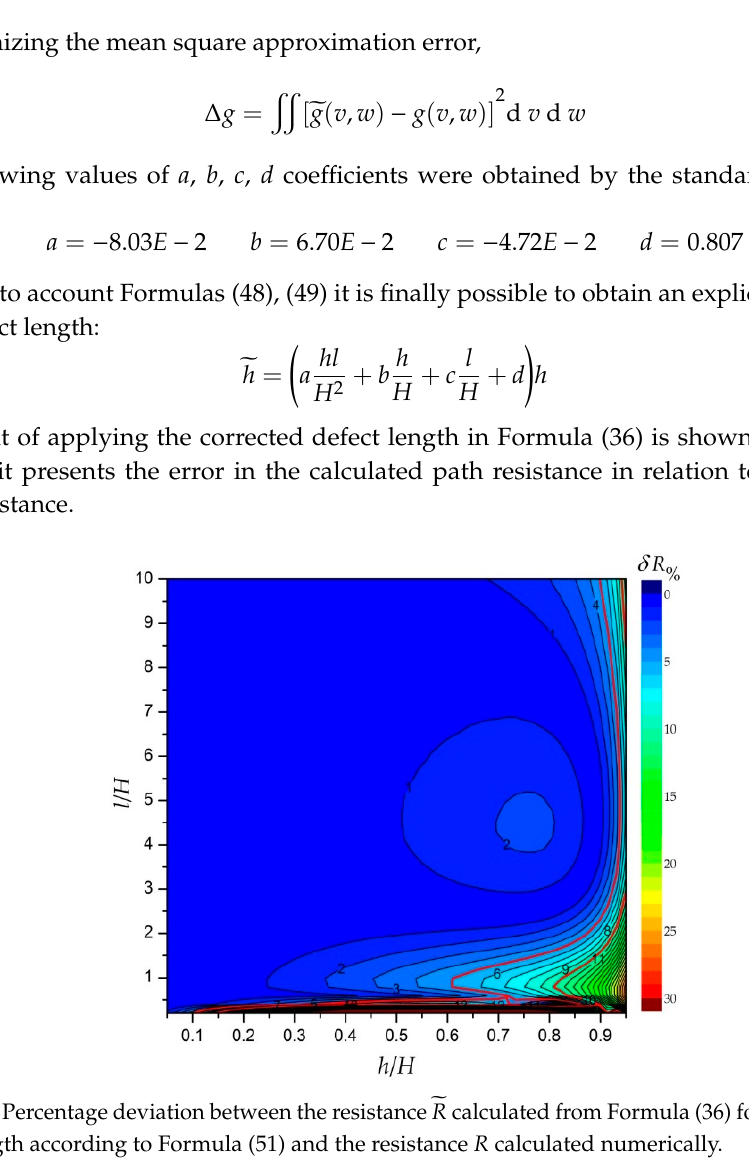
Table 1. The comparison of calculation results according to different models and measurements of the relative resistance R / R 0 of the layer with a defect depending on the relative length of the defect h / H. Analytical calculations Relative Analytical calculations according to the Numerical length of the according to the formula (36)with calculations defect h / H formula (36) correction formula (52)